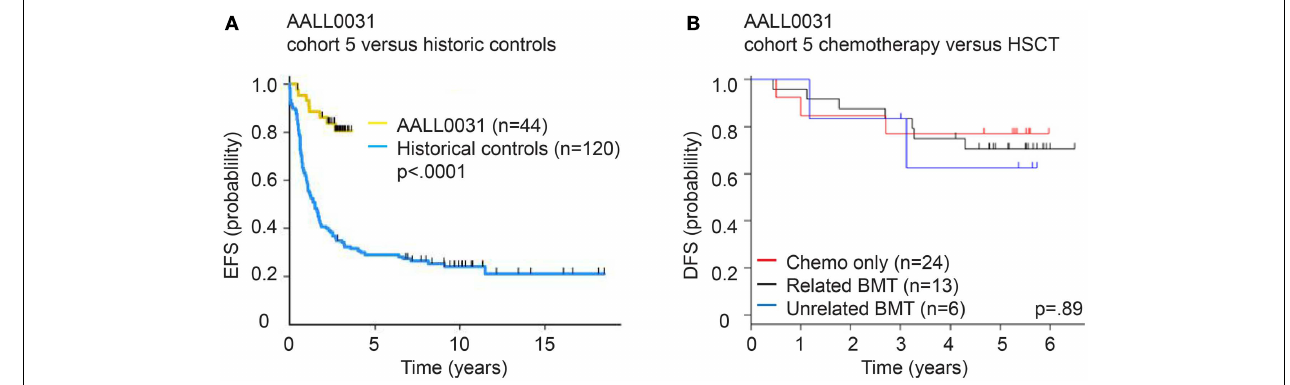
FIGURE 6 | Survival of children with Ph + ALL treated with imatinib + chemotherapy on COGAALL0031 . (A) Event-free survival (early follow-up) of cohort 5 of AALL0031 treated with the MTD of imatinib in combination with chemotherapy compared to historic controls.Thirteen of the 44 patients went on to receive a matched related HSCT, while the remaining 31 patients received chemotherapy only. Introduction of imatinib onto a